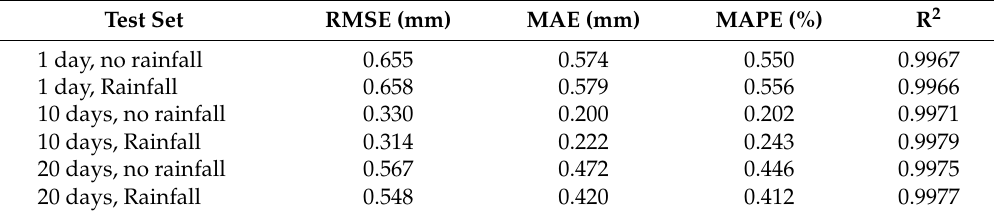
Table 2. Performance evaluation of test set prediction using GA-Elman model.